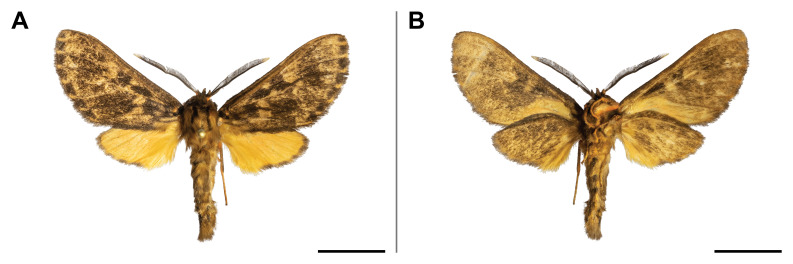
Hippurarctia
judith Kiriakoff, 1959. A. dorsal view; B. ventral view. The scale bar represents 1 cm.